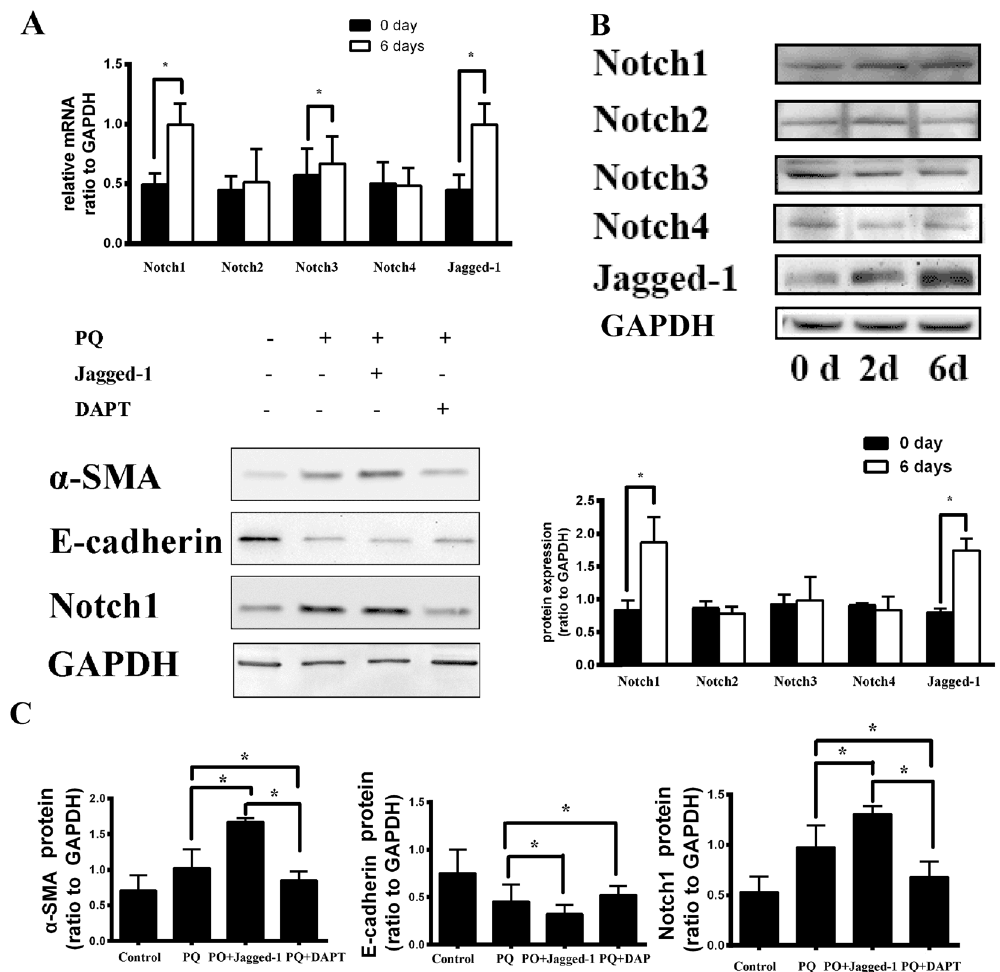
Figure 2. Notch1 signaling is required for PQ-induced EMT-like changes in A549 cells. ( A ) There was a significant increase in mRNA of Notch1, Notch3 and Jagged-1 after A549 cells were exposed to PQ for six days by qRT-PCR. ( B ) There was an apparent increase in expression of Notch1 and Jagged-1 protein by Western-blot analysis. ( C ) After treated with Jagged-1 ligand (ligand of Notch1, 500 ng/mL), a significant increase in α -SMA and Notch1, along with a decrease in E-cadherin protein by western analysis. However, after treating with DAPT (a γ -secretase inhibitor,10 μ mol/L), α -SMA and Notch1 decreased than PQ and PQ + Jagged-1 group. * p <